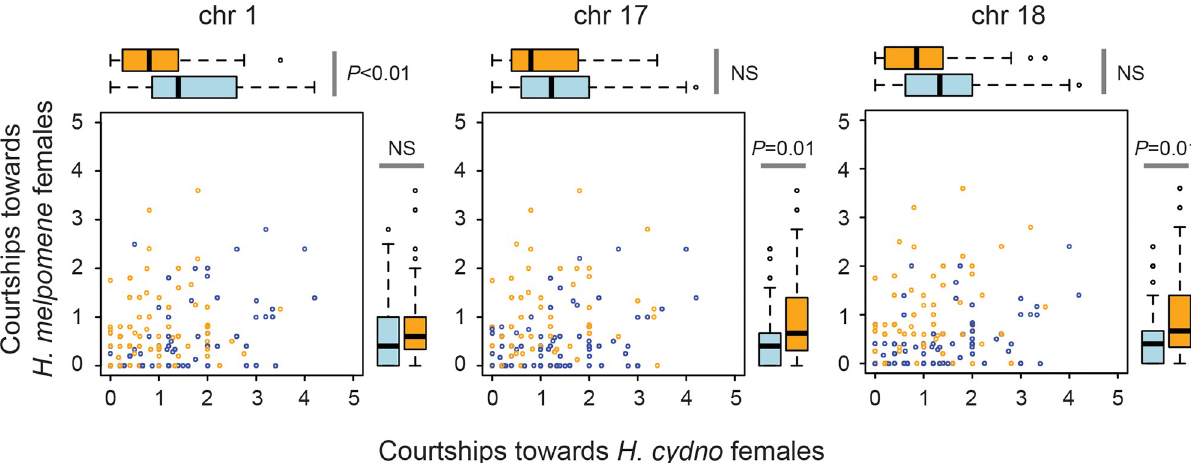
Fig 5. Different QTLs affect different aspects of behavior. The QTL on chromosome 1 influences courtship toward H . cydno but not H . melpomene females. The opposite is the case for the QTLs on Chromosomes 17 and 18, for which there is little evidence that either QTLs influence courtships directed toward H . cydno females. Data presented are for number of courtship events corrected by the total number of trials. Blue circles and boxplots represent data for individuals homozygous at each QTL (i.e., CYD:CYD); orange circles and boxplots represent data for individuals heterozygous at each QTL (i.e., CYD:MEL). Underlying data can be found in the online Dryad repository doi.10.5061/dryad.4b240j4, specifically derived_data/qtl_data. csv. QTL, quantitative trait